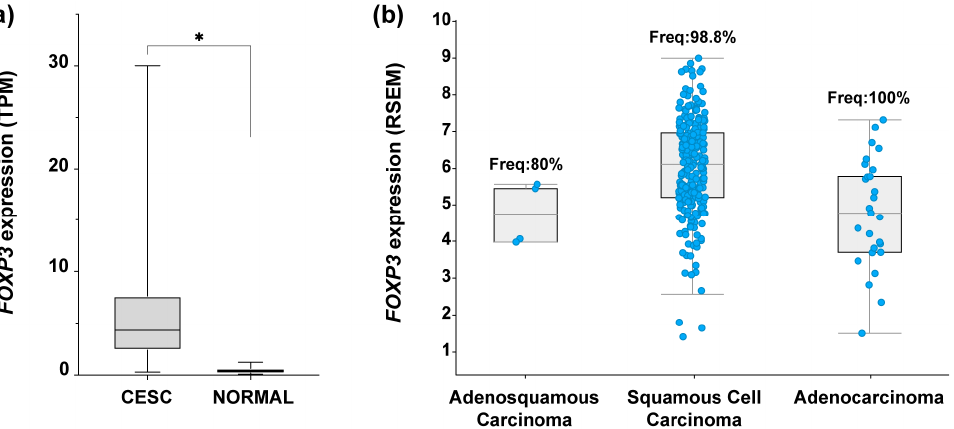
Figure 1. FOXP3 expression levels in cervical cancer. ( a ) Comparison of FOXP3 expression levels in transcript per million (TPM) from cervical epithelial squamous carcinoma (CESC) samples ( n = 304, avg = 5.7, median = 4.3) vs. normal tissue (NORMAL) ( n = 22, avg = 0.4, median = 1), Log2(Fold Change) = 2.1; ( b ) FOXP3 expression abundance in RNA Seq by expectation-maximization (RSEM) from TCGA-CESC data; RSEM values are expressed as RNA Seq V2 RSEM (Log2(value + 1)). Each blue dot represents a patient sample positive for FOXP3 expression: adenosquamous carcinoma, n = 4 of 5 (frequency = 80%), squamous cell carcinoma, n = 253 of 256 (frequency = 98.8%), adenocarcinoma, n = 27 of 27 (frequency = 100%); TCGA-CESC, n = 308 patients. (*) depicts statistical significance with a p -value < 0.05.